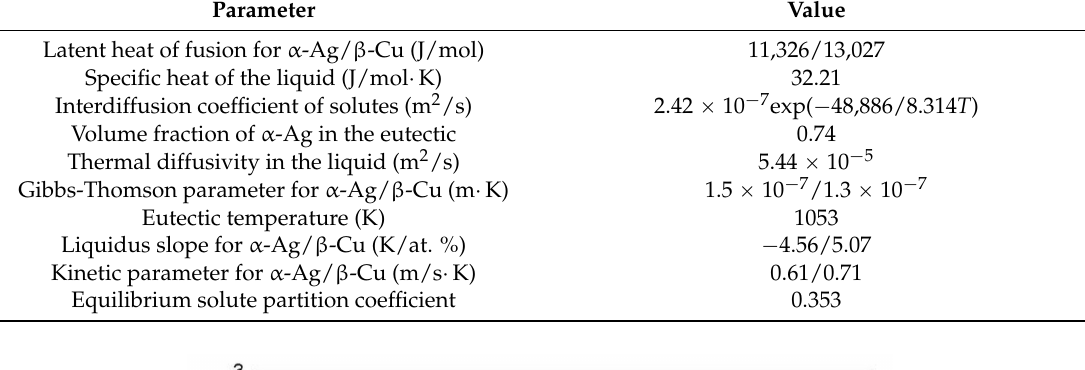
Table 1. Physical parameters of Ag-Cu eutectic alloy [21,22].